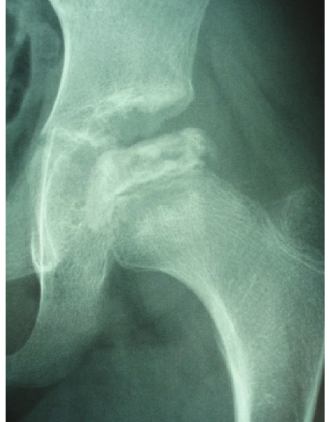
Figure 7: Plain radiograph of the left hip joint 8 months after the initial visit. We categorized the disease as Catterall group II and Herring group B.